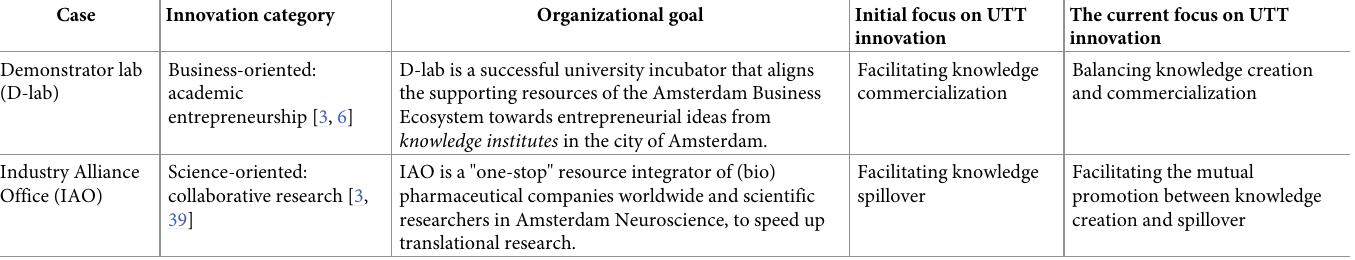
Table 1. Description of